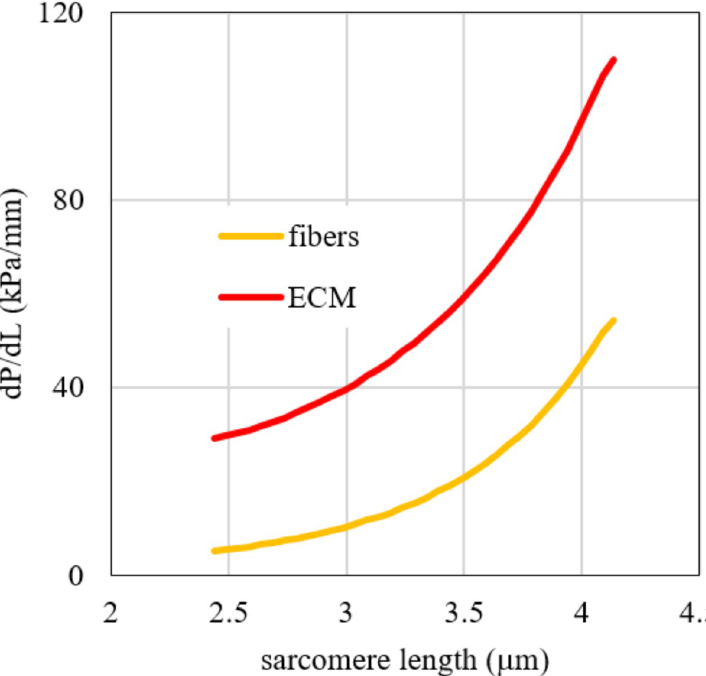
Fig 6. Tangent stiffness vs. sarcomere length. Tangent stiffness vs. sarcomere length for fibres (sum of fast and slow) and ECM, as obtained by the fitting procedure of Eq (9) to experimental data of bundles. The tangent stiffness is here defined as the slope of the stress vs. sarcomere length curve of the bundles.